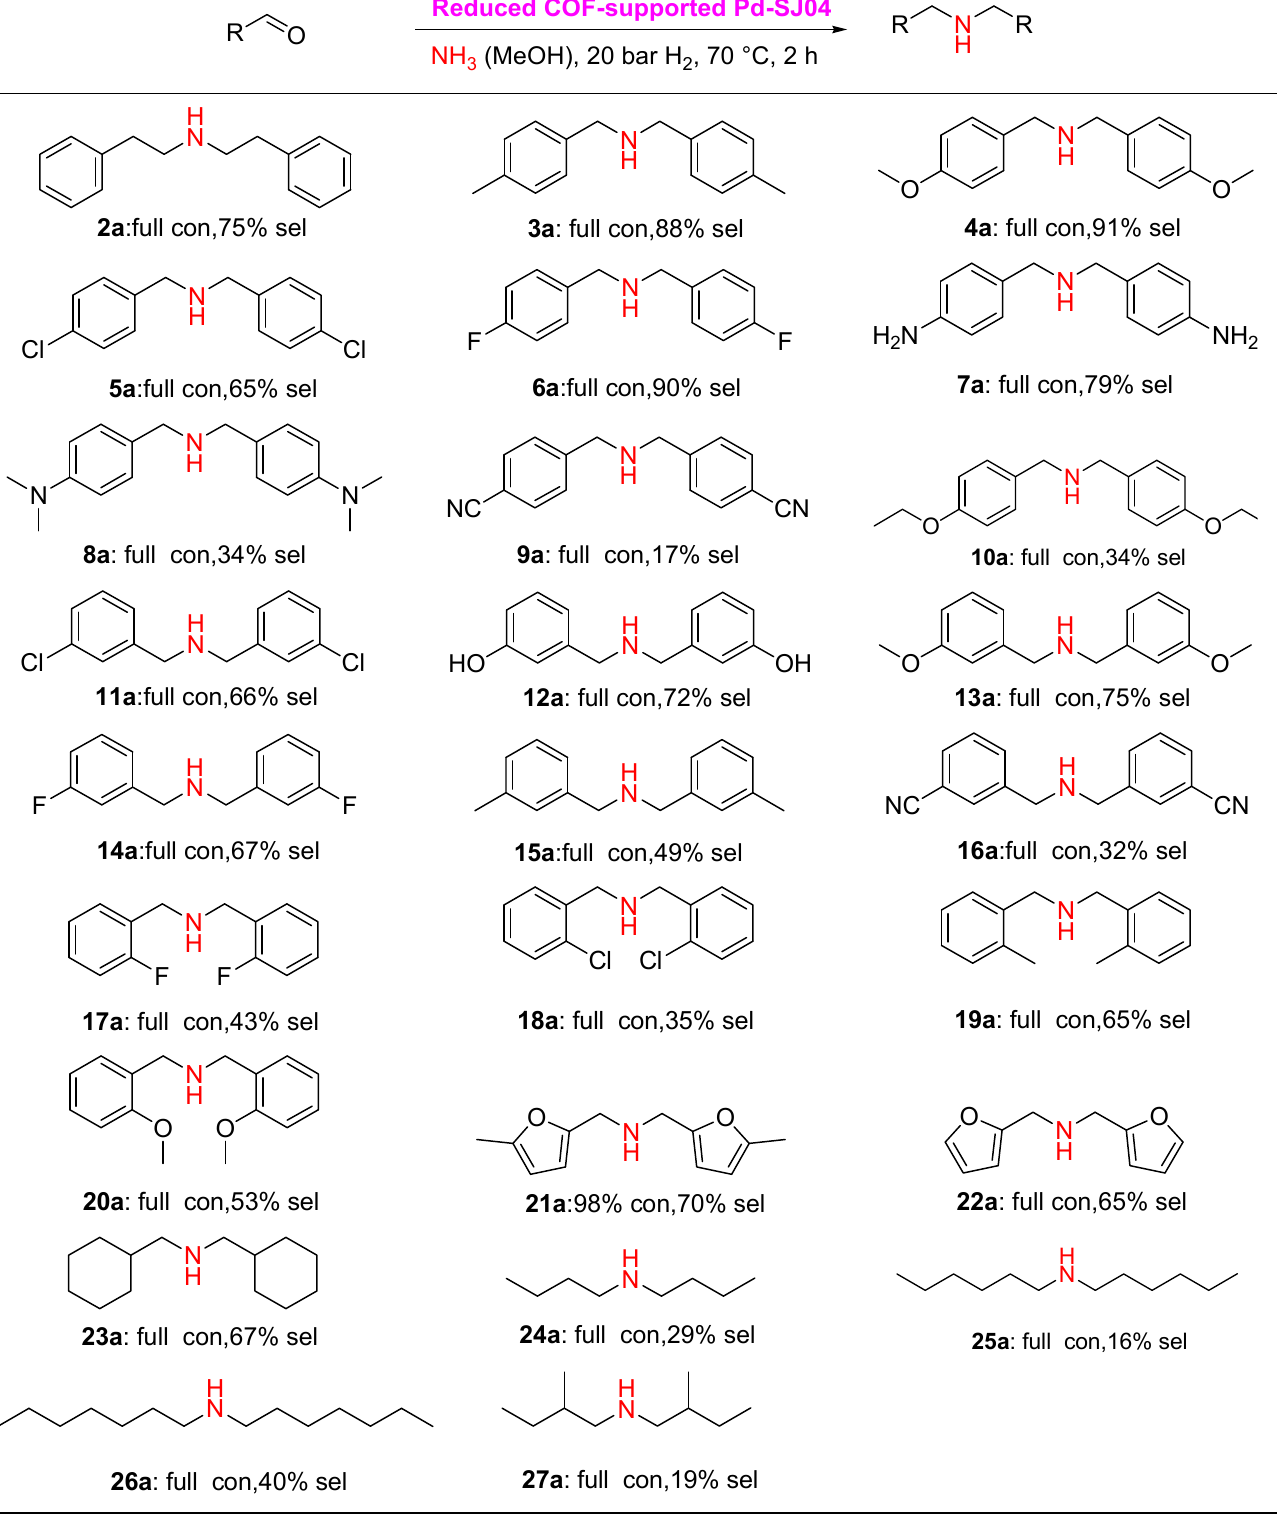
Table 2. Screening of aldehydes to synthesize dibenzylamine homologs. Reduced COF-supported Pd-SJ04